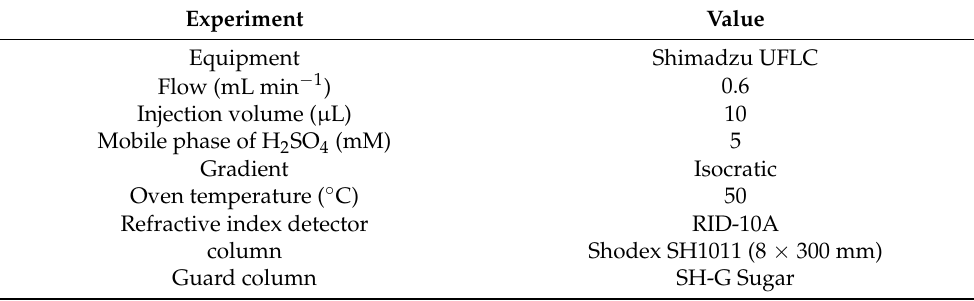
Table 4. The method used in the